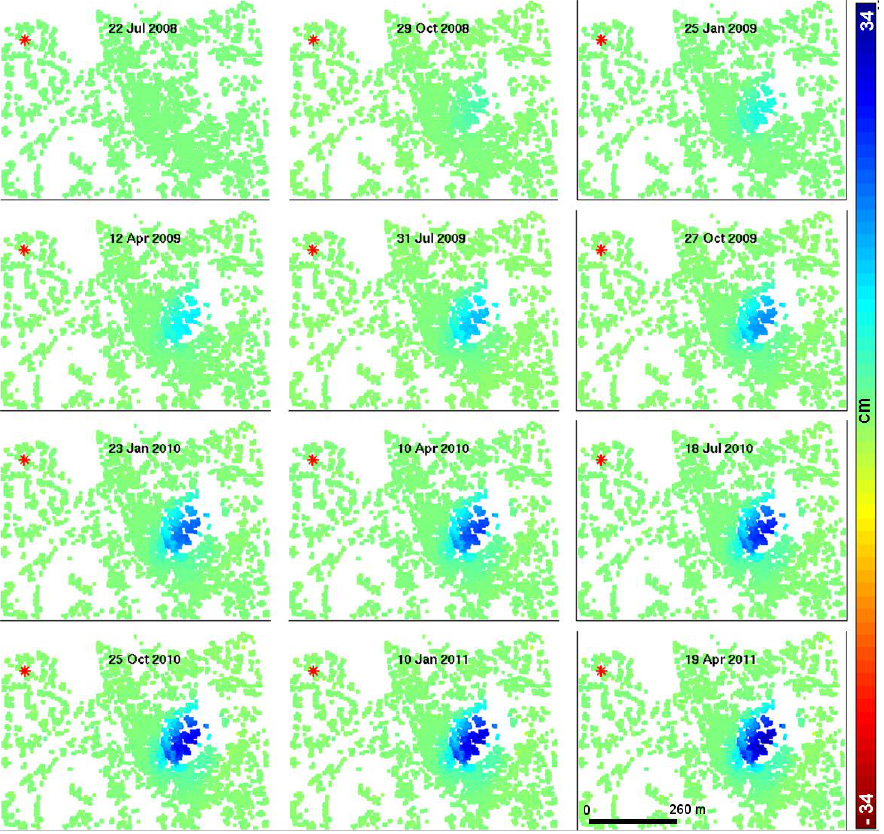
Figure 7. Time series of the LOS displacement in Staufen. For simplicity, the uplift patterns of only 12 of 50 acquisition dates are